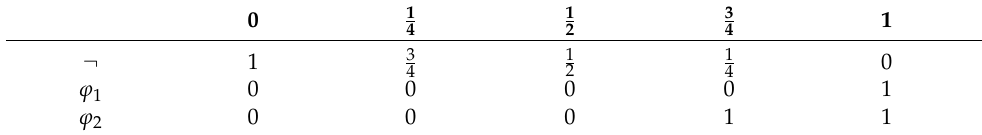
Table 3. Negation operator ¬ and graded operators ϕ 1 , ϕ 2 on L 5